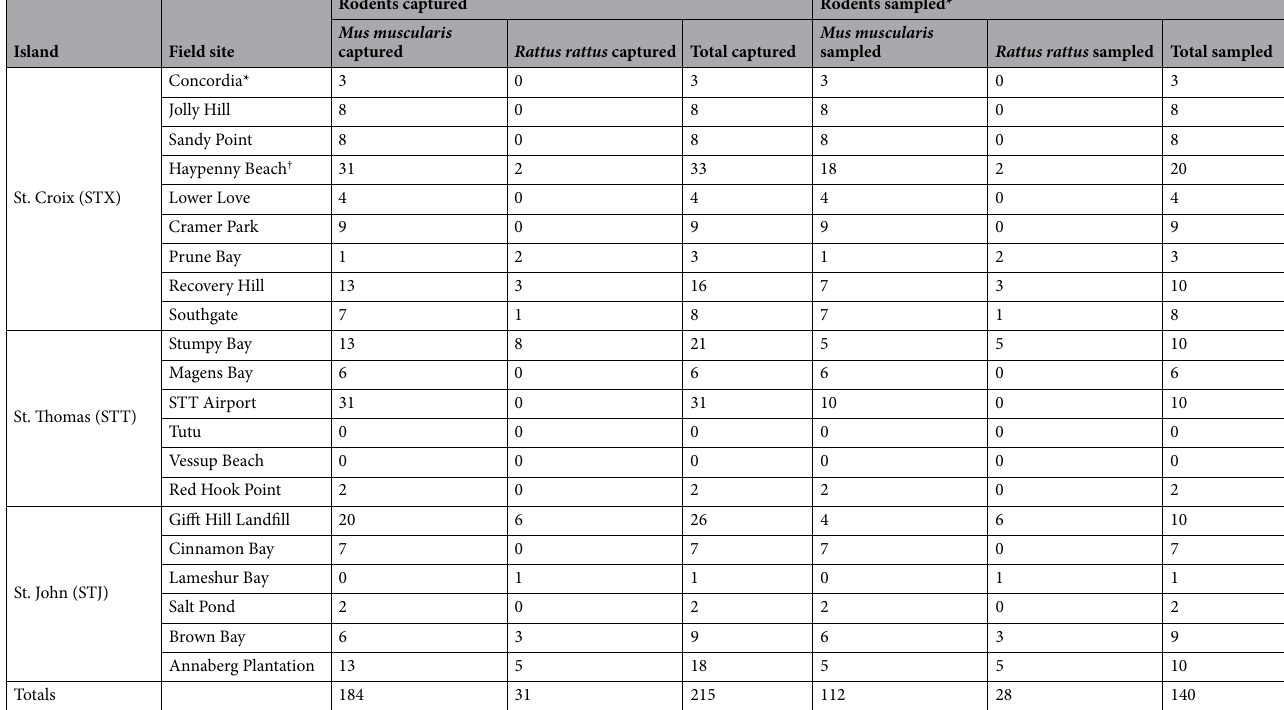
Table 1. Number of rodents captured and sampled, by island and field site as shown in Fig. 1. *Pilot study site sampled on September 3, 2019; in total, 39 Sherman traps deployed. † Because of laboratory resources and field safety, sampling was limited to 10 rodents per site after sampling at Haypenny